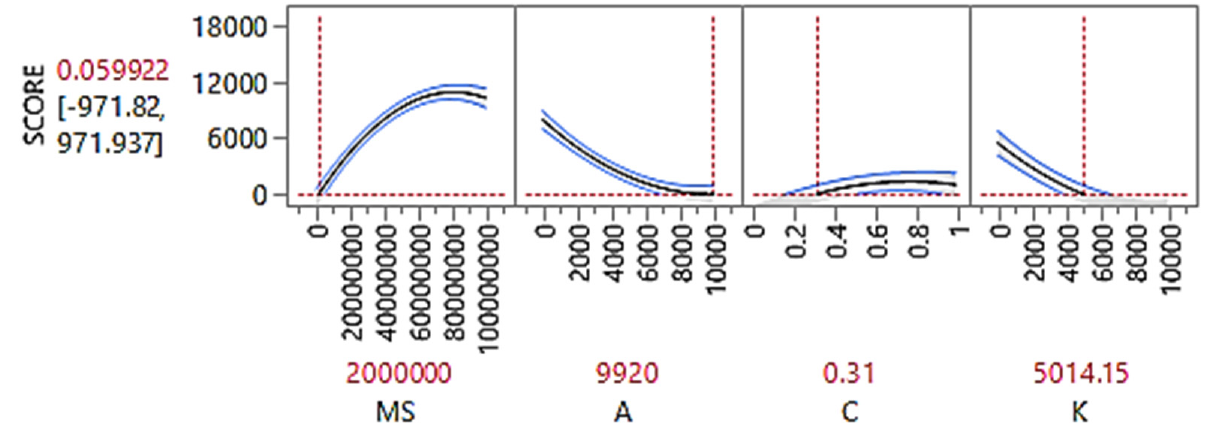
Figure 5. Prediction profiler for the optimized response surface model.